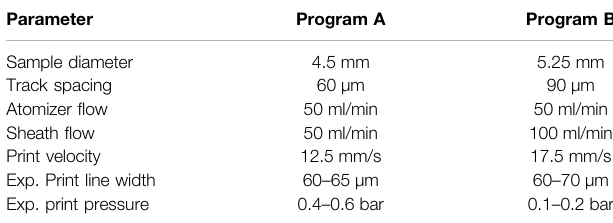
TABLE 1 | Print parameters of samples printed with program A and program B.